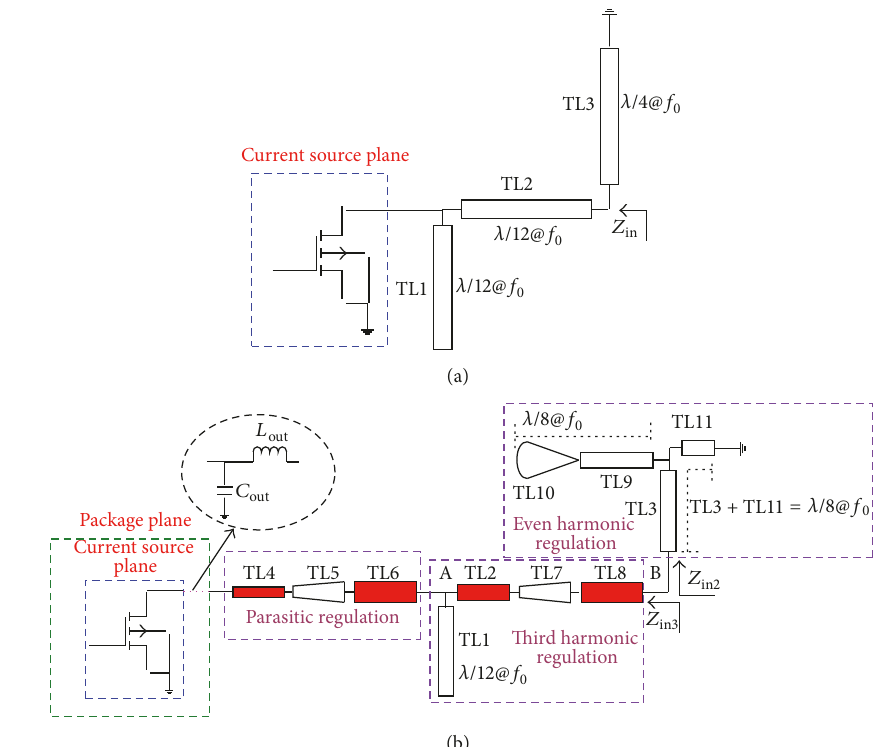
Figure 2: Circuit design of (a) conventional and (b) improved harmonic control